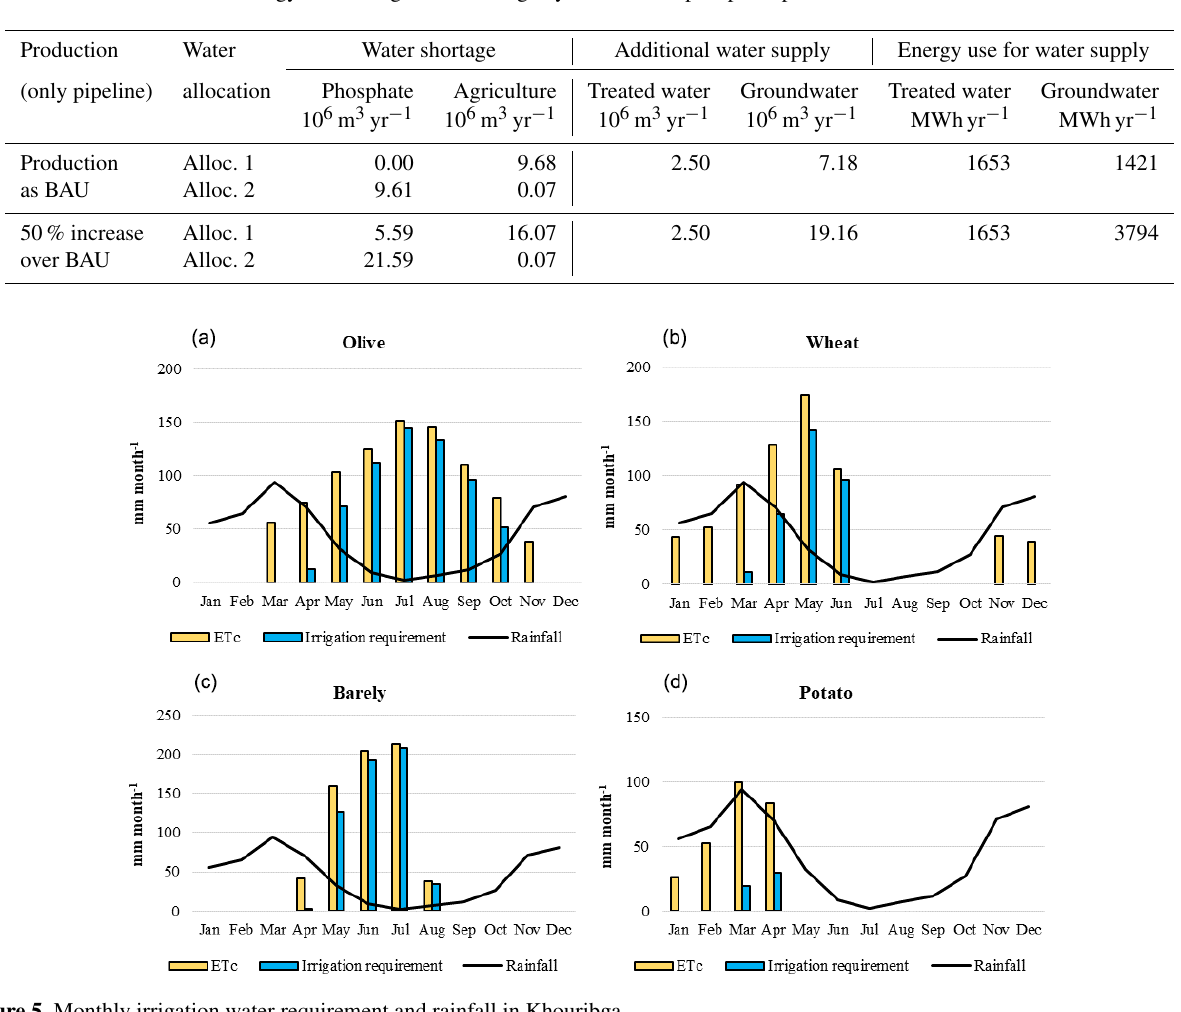
Table 9. Additional water and energy for solving water shortage by scenarios of phosphate production.